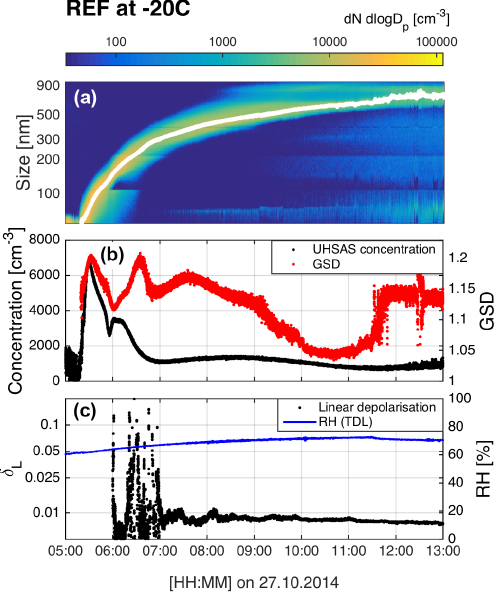
Figure 4. Overview of RUN2 at − 10 ◦ C. The particle size distri- bution and the GMD from a log-normal fit are shown in panel (a) . Panel (b) shows the total concentration measured with the UHSAS (with 56nm cut-off) and the GSD determined from a log-normal fit. Panel (c) shows the linear depolarization ratio and RH. The RH was kept low during the growth of the SOA particles, allowing them to remain in a viscous state. The RH was raised after about 20:15UTC in order to measure its value at the particle phase transition from highly viscous to low viscosity state. The gradual phase transition began at 21:41UTC and is indicated by the grey area in panel (c) . The top and middle panels show further particle nucleation starting around 19:00UTC; these particles remained relatively small and did not affect the measurement.